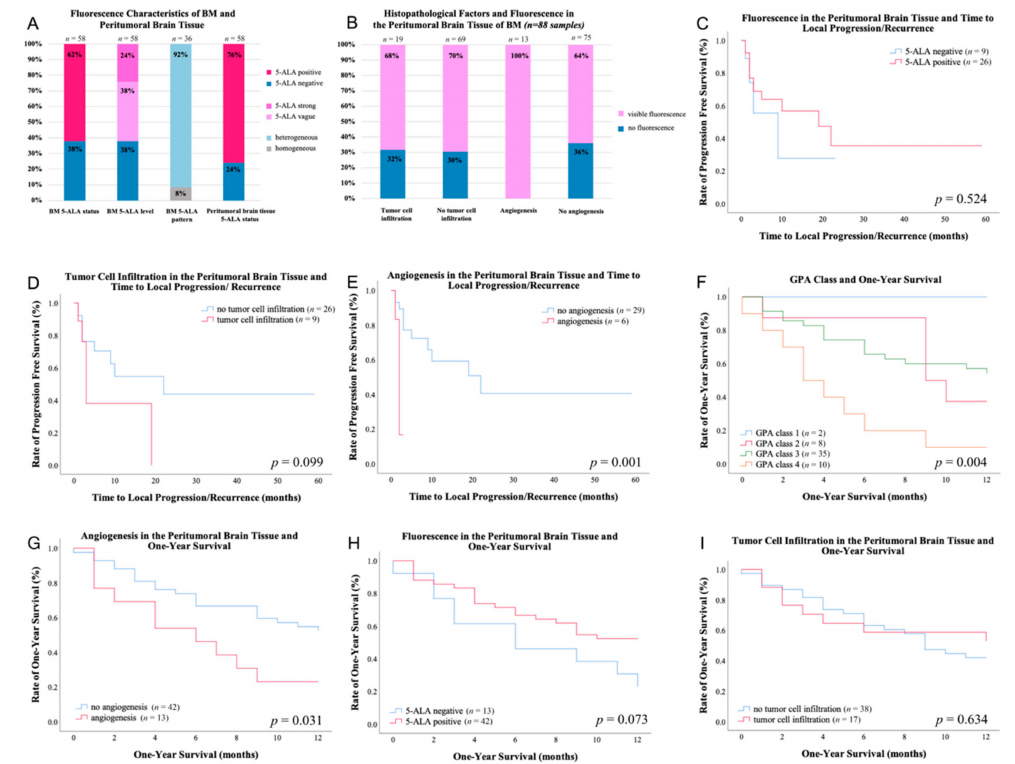
Figure 1. Illustration of intraoperative fluorescence characteristics in brain metastases/peritumoral brain tissue, histopatho- logical correlate and postoperative follow-up. ( A ) 5-ALA fluorescence characteristics of the BM (fluorescence status, level and homogeneity) and the 5-ALA fluorescence status of the peritumoral brain tissue. ( B ) 5-ALA fluorescence status in samples ( n = 88) from peritumoral brain tissue with presence or absence of tumor cell infiltration and angiogenesis. It is of note that angiogenesis was found only in tissue samples with visible 5-ALA fluorescence. ( C – E ) The Kaplan–Meier curves indicate the time to local progression/recurrence dependent on specific factors in the peritumoral brain tissue including ( C ) the 5-ALA fluorescence status, ( D ) tumor cell infiltration and ( E ) angiogenesis. It is of note that we found a significantly shorter median time to local progression/recurrence in brain metastases with presence of angiogenesis (2 months) compared to BM without angiogenesis in the peritumoral brain tissue (22 months; p = 0.001). ( F – I ) The Kaplan–Meier curves indicate the one-year survival rates dependent on ( F ) the GPA class as well as ( G ) angiogenesis in the peritumoral brain tissue, ( H ) the 5-ALA fluorescence status and ( I ) tumor cell infiltration in the peritumoral brain tissue. A significant correlation